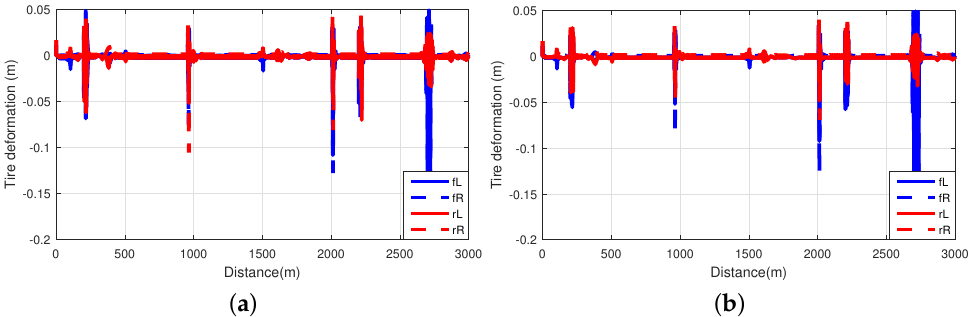
Figure 17. ( a ) Tire deformation without adaptive control. ( b ) Tire deformation with adaptive